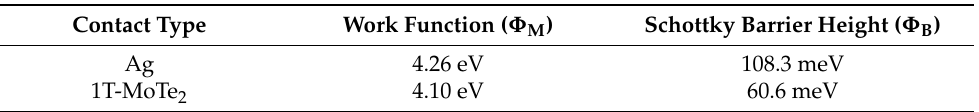
Figure 7. The Arrhenius plot. The ln( I 2D / T 2/3 ) against 1000/T for various V for ( a ) Ag and ( c ) 1T-MoTe 2 interlayer electrode contacts of 2H-MoTe 2 . Extracted of via Φ B the y intercept value of ( b ) Ag and ( d ) 1T-MoTe 2 interlayer electrode contacts of 2H-MoTe 2 . Table 2. The Schottky barrier heights of Ag and 1T-MoTe 2 interlayer electrode contacts determined from 2D thermionic emission model.